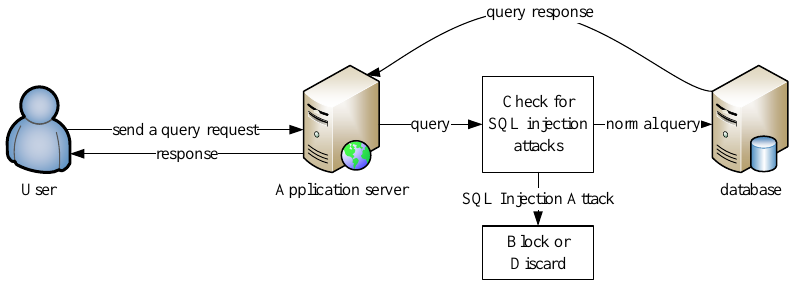
Figure 2. Traditional detection methods.